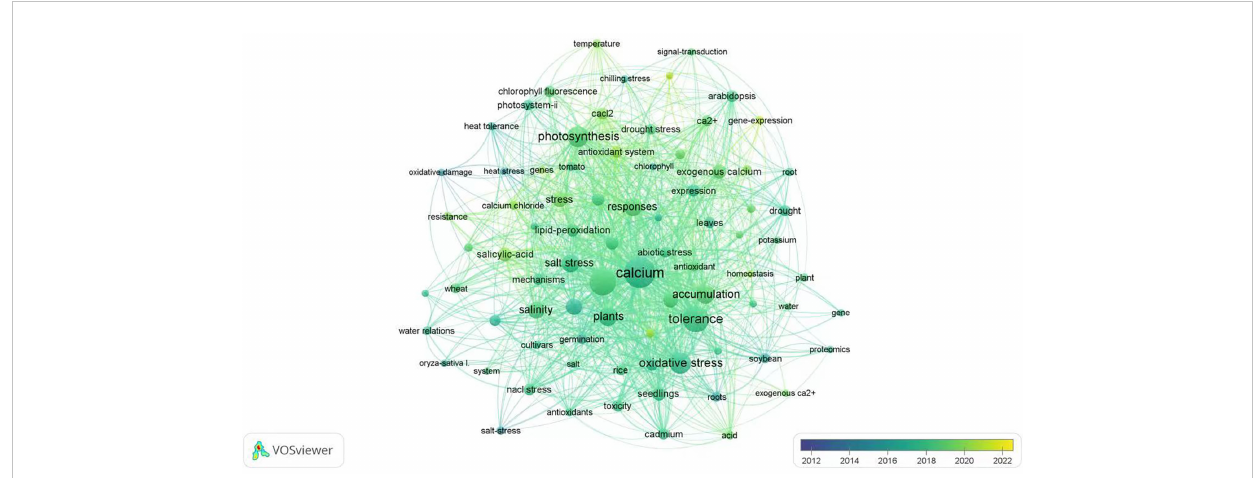
FIGURE 1 Hotspot analysis of English literature on “ exogenous calcium ” and “ stress ” in the last 10 years. The size of each dot represents the focal weight of each key word in the literature and the lines between two dots indicate their coupling